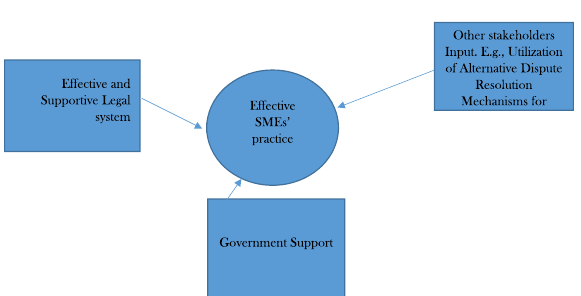
Fig. 1 Proposed-model for effective SME practice in Nigeria. Source: The Authors ’